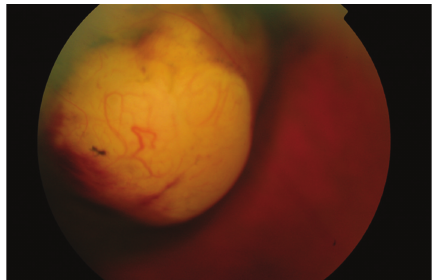
Figure 6: Amelanotic choroidal melanoma. Choroid vessels are visible through the tumor.